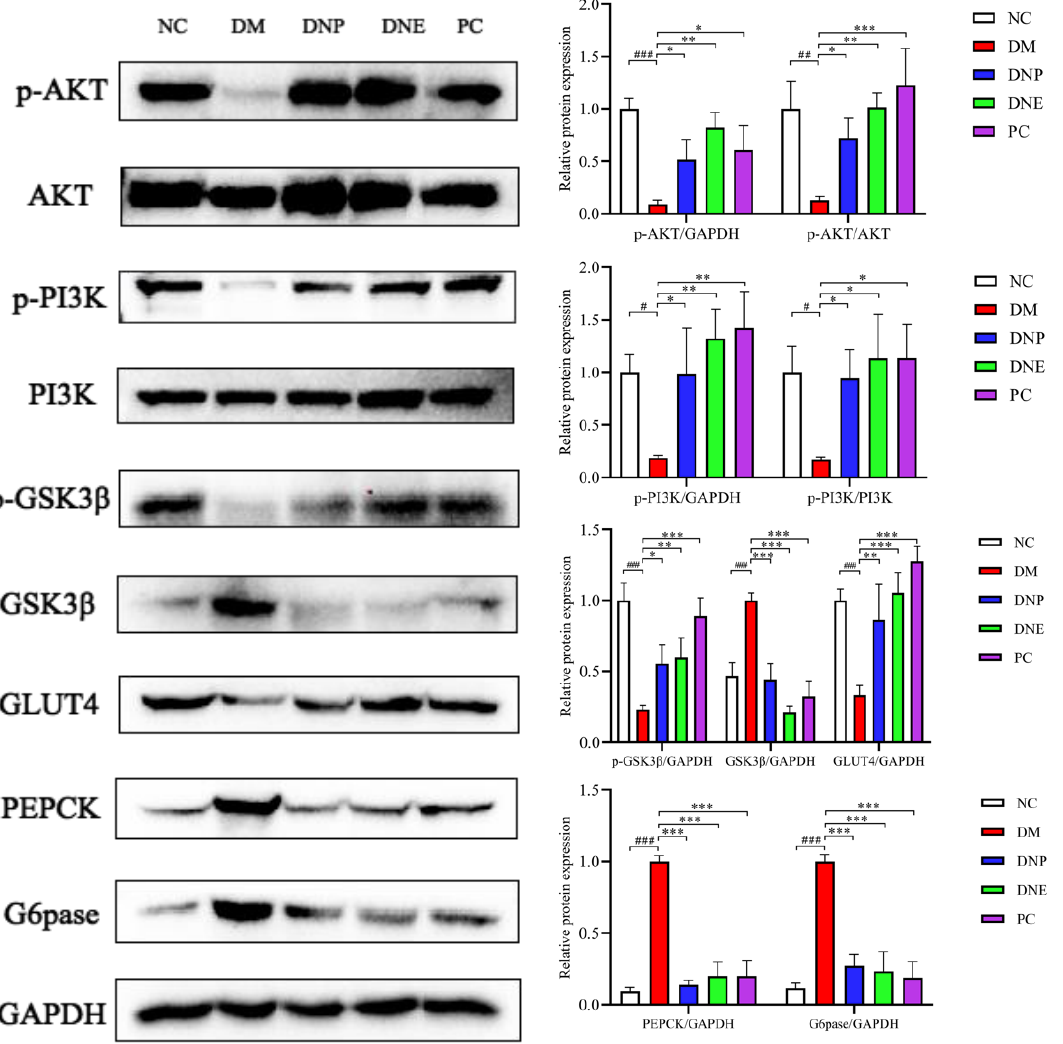
Figure 18. Effects of D. nobile on the expression of P-PI3K, P-PI3K/PI3K, P-Akt, P-Akt/Akt, PEPCK, G6Pase, p- GSK3β, GSK3β and GLUT4 proteins in the liver of T2DM rats. Compared with the NC group, # p < 0.001, ## p < 0.001, and ### p < 0.001; compared with the DM group, * p < 0.01, ** p < 0.01, and *** p < 0.001.